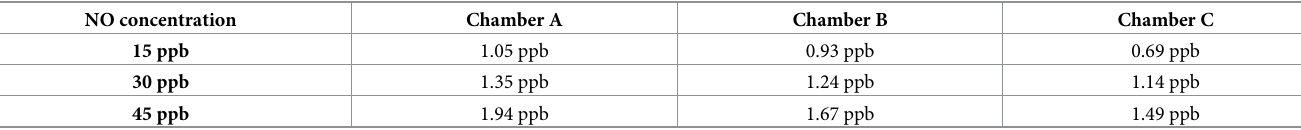
Table 5. Errors of the three bionic sensing systems. NO concentration